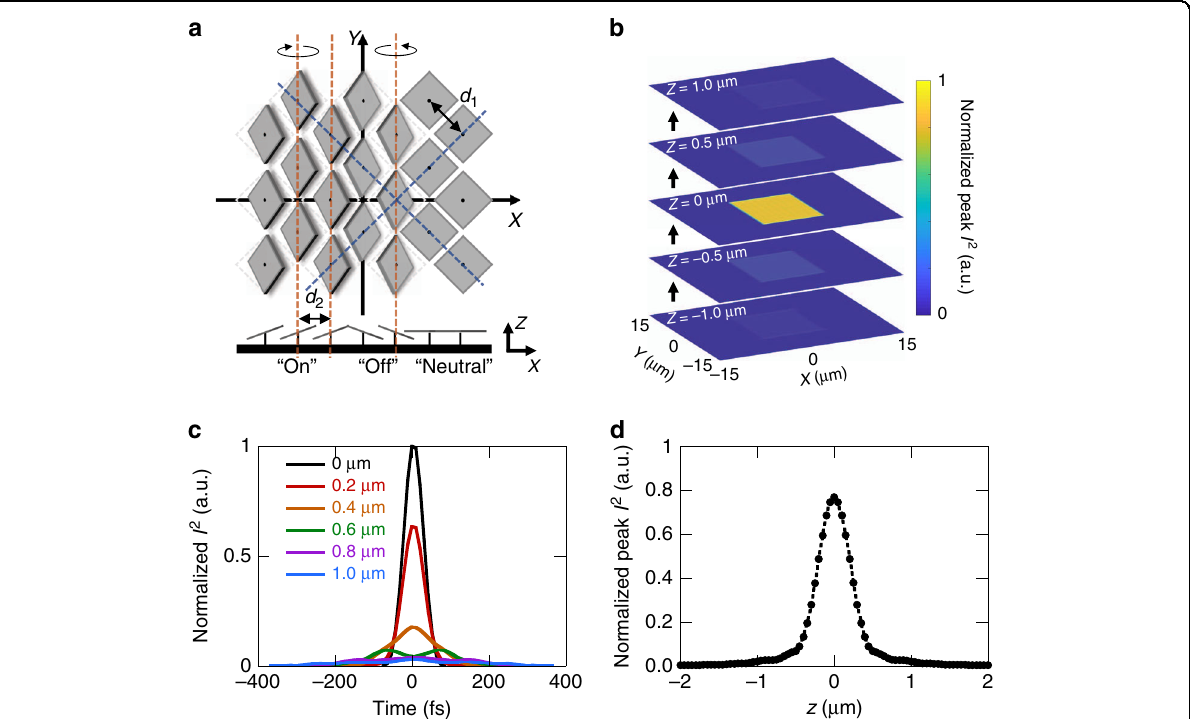
Fig. 2 Simulation of spatiotemporal focusing. a DMD grating orientation. Blue dashed lines indicate the 2D grating with separation d 1 formed by the mirror grid spacing. Orange dashed lines indicate the 1D grating with separation d 2 formed by mirror tilt. Bottom part of fi gure indicates corresponding DMD mirror tilts for pixels in the “ on, ” “ off, ” and “ neutral ” states. b Simulated xy -plane pro fi les of peak I 2 for progressive z -positions along the propagation direction of the spatiotemporal focusing near the print plane for a 1.52 mm × 2.28 mm rectangular pattern of DMD pixels being spatially and temporally focused. c Normalized I 2 of the laser pulse pro fi le in time for select z -positions along the center (optical axis) of the pattern from b . d I 2 values for different z -positions along the center (optical axis) of the pattern from